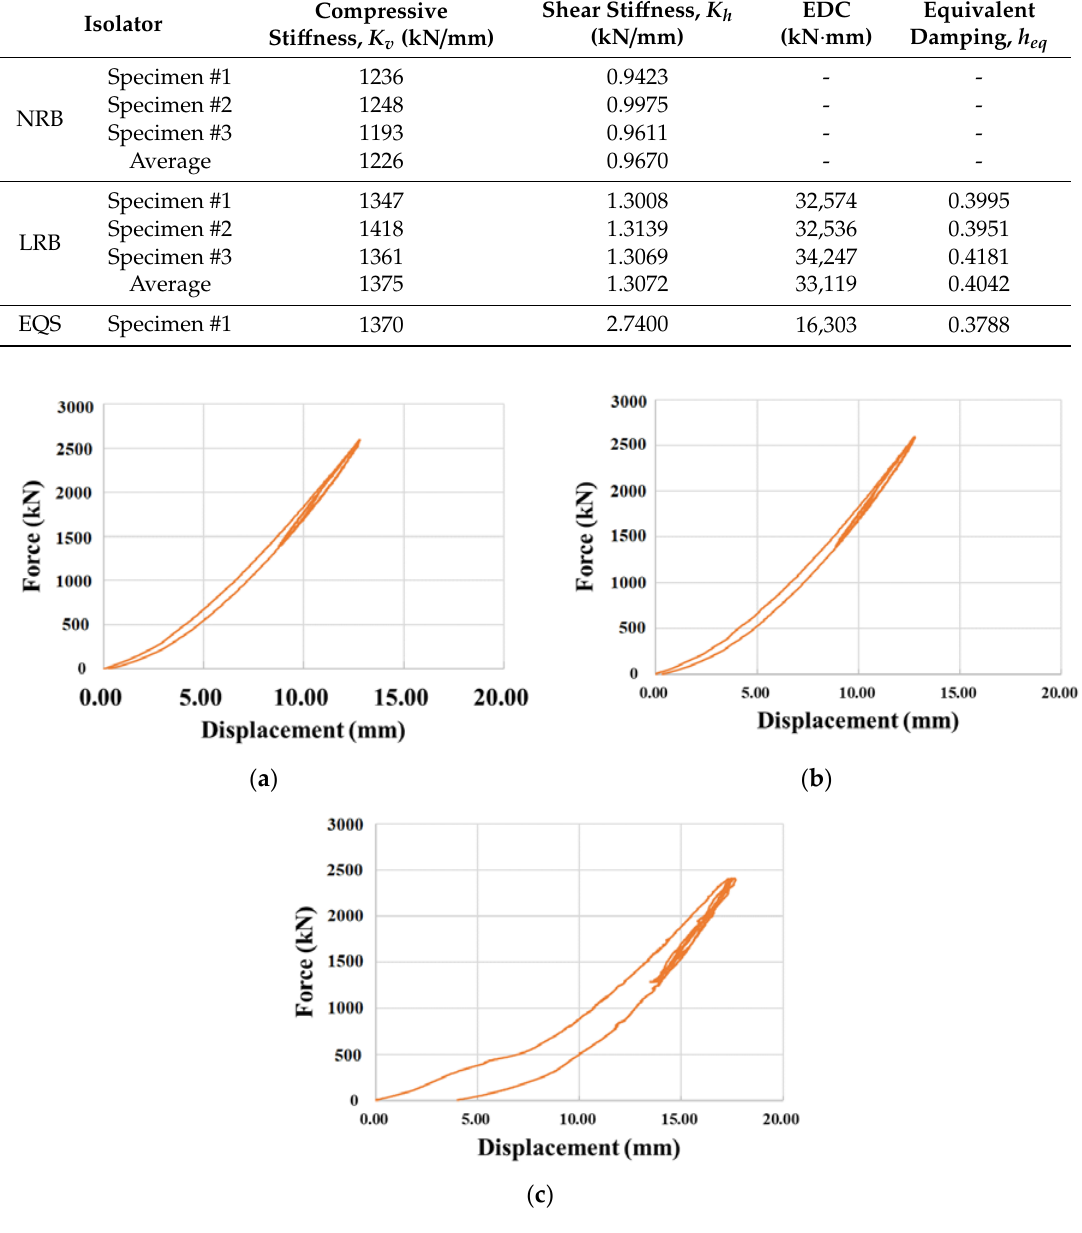
Figure 8. Measured compressive force–displacement curves: ( a ) NRB; ( b ) LRB; ( c )